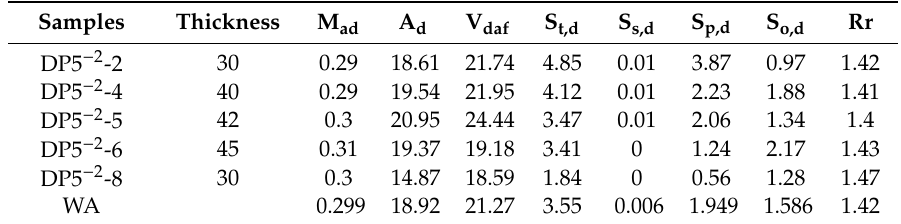
Table 1. Coal bench thickness (cm), proximate analysis (%), sulfur (%), and random vitrinite reflectance (%) of the No. 5 − 2 coal from Dongpo